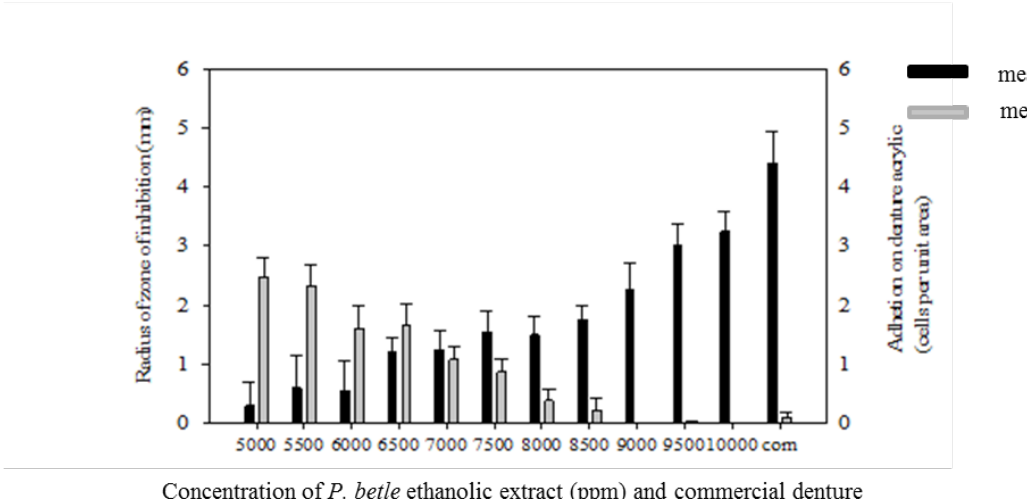
Figure 3: Effect of P. betle leaf ethanol extract and commercial denture cleanser on C. albicans (ATCC 90028) inhibition and